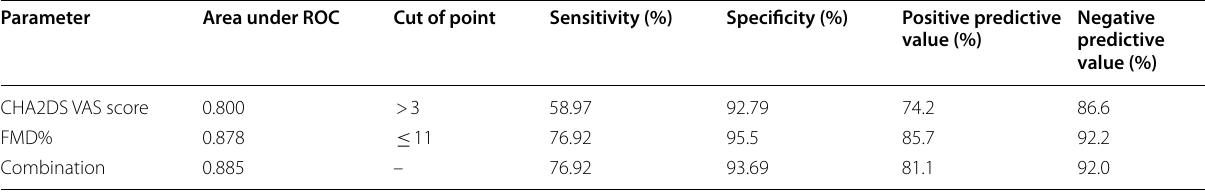
Table 6 The cut off values for prediction of no reflow using the CHA2DS VASc score and the brachial artery